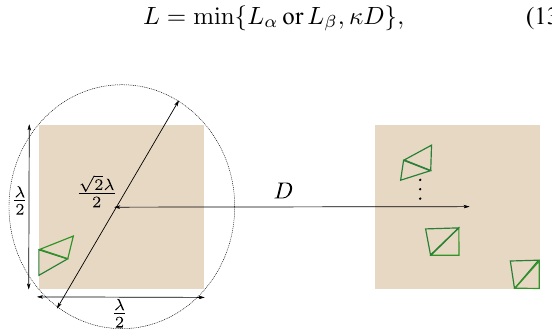
Figure 2: Scatterer benchmark consisting of two square PECs separated a distance D , where D used for the numerical experiment to set a proper value of multipoles L